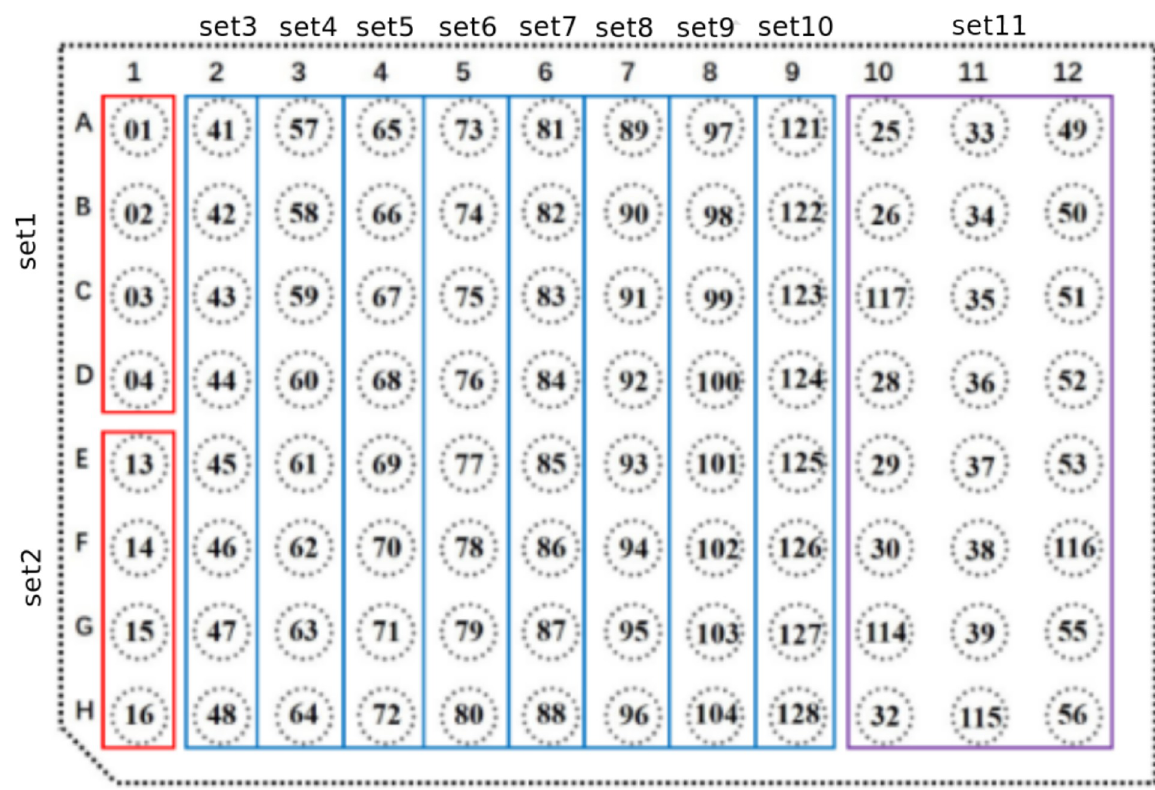
Fig 1. 11 main compatible sets of barcodes according to the manual for MGISEQ-2000 [5]. Sets are highlighted with colored rectangles and signed around the perimeter.